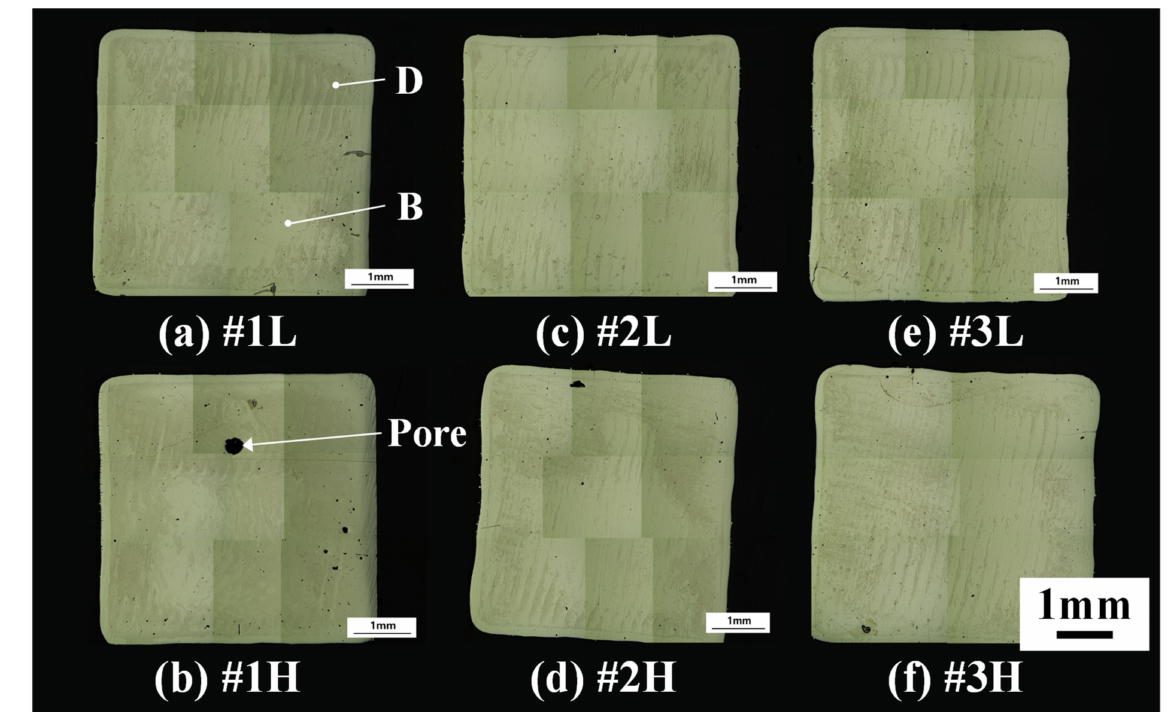
Figure 2. Micrographs of the Ti-based BMGs according to the LPBF process conditions. ( a ) #1L (80 W, 1200 mm/s), ( b ) #1H (160 W, 2400 mm/s), ( c ) #2L (80 W, 1029 mm/s), ( d ) #2H (160 W, 2057 mm/s), ( e ) #3L (80 W, 900 mm/s), and ( f ) #3H (160 W, 1800